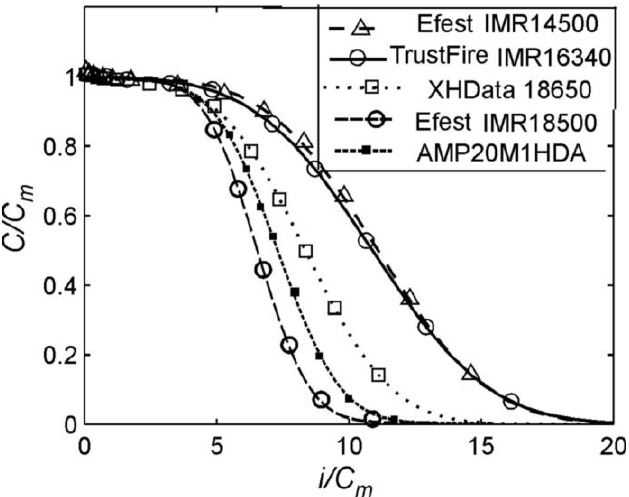
Figure 2. Approximation of experimental data using Equation (10) for different lithium-ion cells. C m values were taken from Table 1 for each cell. Table 1. Optimal parameters of generalized Peukert equations (Equations (8) – (10)) for the studied lithium-ion cells.